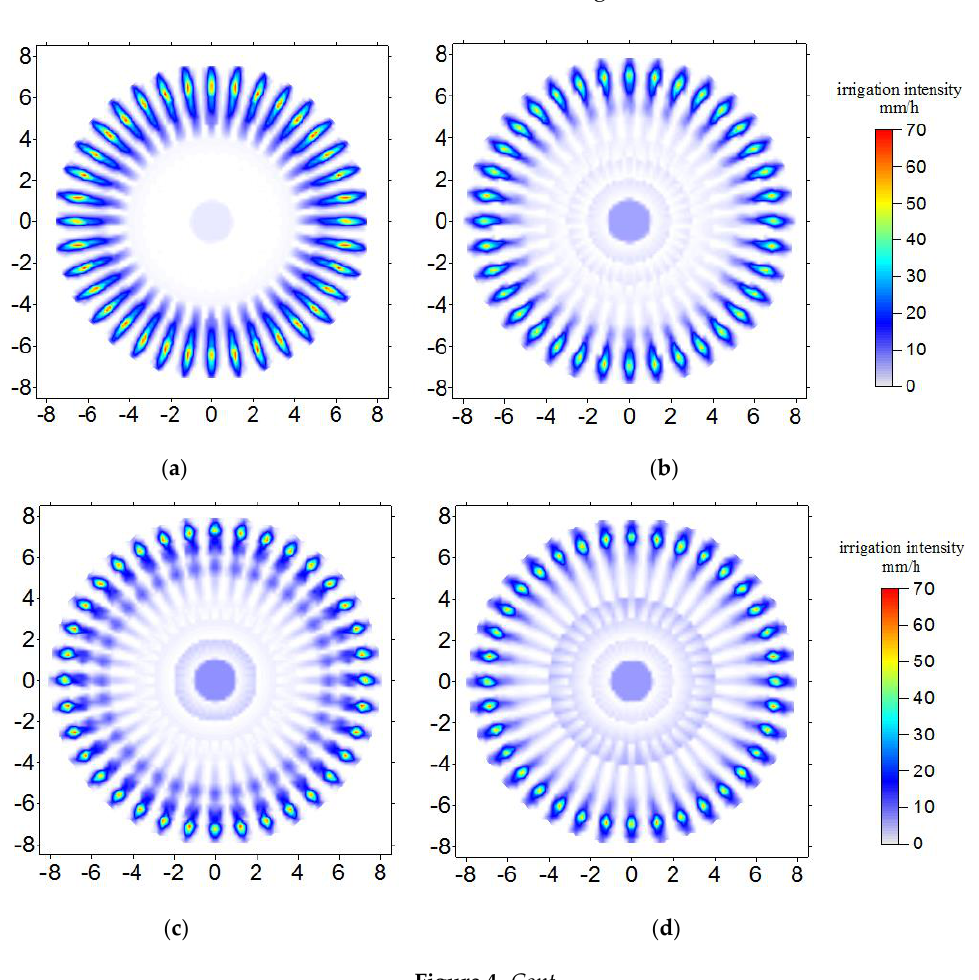
( f ) Figure 4. The effect of sediment contents on water distribution pattern with 1.5m mounting height at 150kPa. Note:( a )clean water,( b )1% sediment content, ( c )2% sediment content, ( d )3% sediment content, ( e )4% sediment content, ( f )5% sediment content. 3.3. Spray Distance Spray distance is an important parameter, which decides the overlapping space in sprinkler ’s irrigation design. Table 2 presents the spray distance with different sediment concentrations. For the same working pressure,wetted radiuses irrigated with sediment-water were larger than clean water, the increasing ratio of spray distance for 100 kPa ranged from 2.42%~6.25% with different mounting heights, and the maximum increasing ratio was7.79% and 6.74% when the working pressure increased from 150 kPa to 200 kPa. For the same sediment concentration and working pressure, the increasing trend of spray distance was notobvious at increased mounting height. In addition, the increase in sediment concentration contributed to the increase in spray distance, althoughregulation of the fluctuations affected by concentration was not obvious. This phenomenon mightresult in the probability of elastic collision as sedimentsstruck on the deflector plate.For a high sediment concentration, the probability value of the elastic collision event was high, thenmore water wouldbe peeled out the water jet,and the jetcrashed by the sediment scattered in all directions, leading to the changeinspray distance.